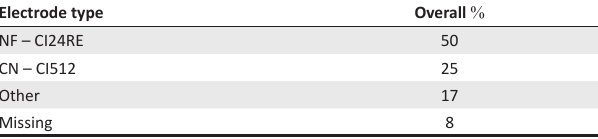
TABLE 2: Electrode types for participants in the current study ( N = 60).